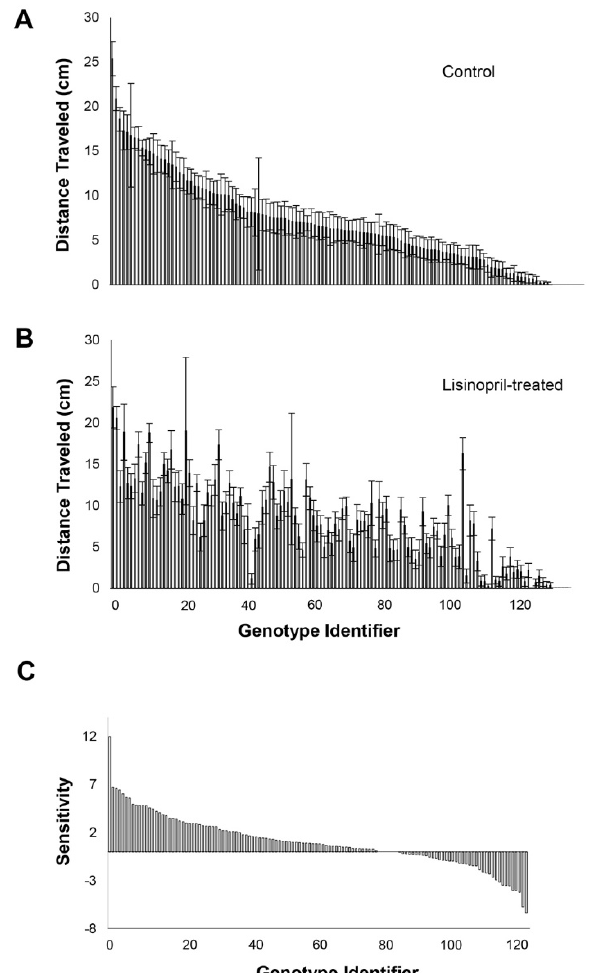
Figure 2. Effects of Lisinopril on endurance, sensitivity, and magnitude of response at old age depend on genotype. ( A ) Endurance (distance travelled) at old age in flies fed control food, ranked by highest to lowest mean climbing speed. ( B ) Endurance at old age in flies fed Lisinopril-treated food, ranked by control at old age. ( C ) There is significant variation among genotypes in the sensitivity of endurance to Lisinopril treatment at old age. “Genotype identifier” is a numbering system representing the 126 DGRP lines. These are ranked by their sensitivity, at age old age, from most to least sensitive. Positive values indicate greater endurance (longer distance travelled) in Lisinopril treatment relative untreated controls; negative values indicate shorter distance travelled relative to untreated controls. Table 2. GWA of effect of Lisinopril treatment on physical performance and the sensitivity of age- specific climbing speed and endurance to Lisinopril treatment.